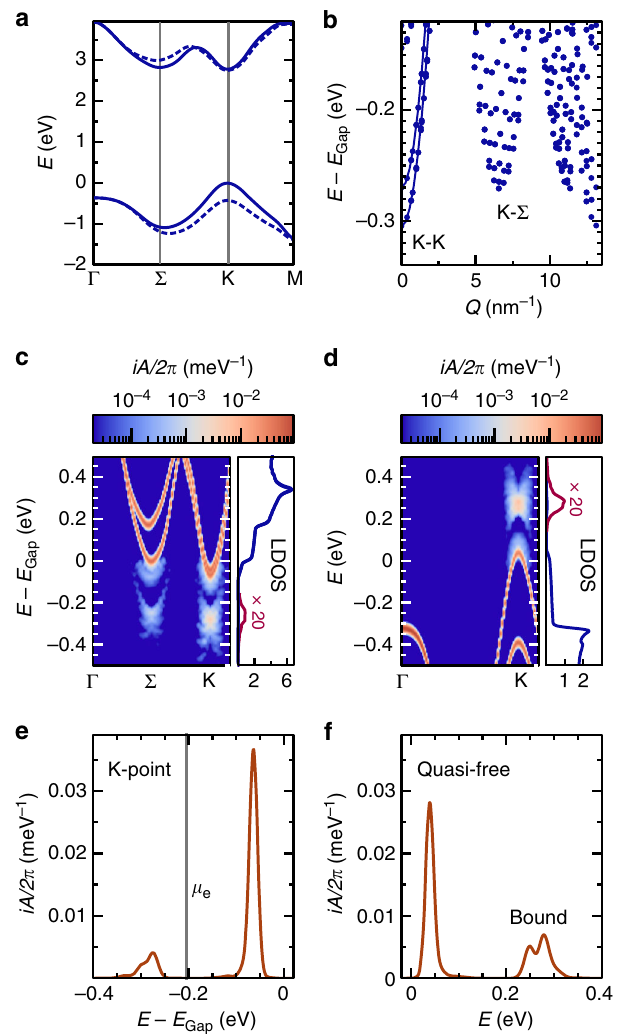
Fig. 1 Spectral properties of excited carriers in monolayer WS 2 . a Band structure of freestanding WS 2 as obtained from a G 0 W 0 calculation at zero excitation density, including spin-orbit interaction. b Bound-state spectrum for WS 2 on SiO 2 substrate relative to the quasi-particle gap at zero excitation density over the modulus of total exciton momentum Q as obtained from a Bethe – Salpeter equation, see Eq. (16) in the “ Methods ” section. Excitons involving the Γ , K ′ and Σ ′ valleys are included but not marked explicitly. The lines serve as guide to the eye for the K -exciton dispersion. c Electron spectral function in extended quasi-particle approximation at T = 300 K and excitation density n a = 3.2 × 10 12 cm − 2 showing resonances from bound and quasi-free particles in momentum- resolved representation and as normalized local density of states. Energies are measured relative to the quasi-particle band gap at zero excitation density. A phenomenological Gaussian broadening of 10 meV (HWHM) is applied. d Hole spectral function in extended quasi-particle approximation. e Electron spectral function as in c for spin-down electrons at the K -point. The vertical line marks the electron chemical potential. f Hole spectral function as in d for spin-up holes at the K